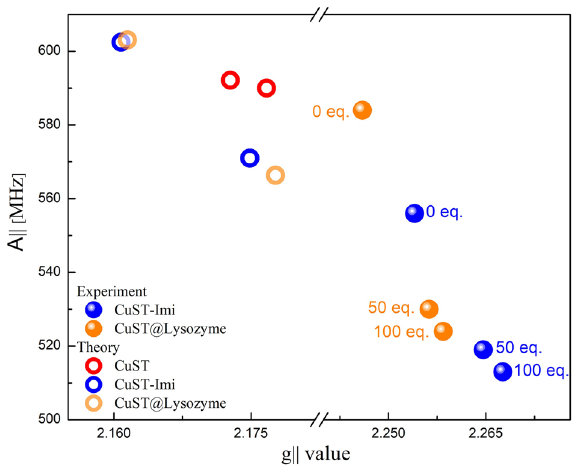
Figure 13. Changes in g // and |A // | values of CuST (red circle), CuST-Imi (orange circles) and CuST@lysozyme (blue circles) upon addition of 0, 50, and 100 eq. of NaN 3 . The filled and empty circles denote the experimentally and theoretically obtained values,